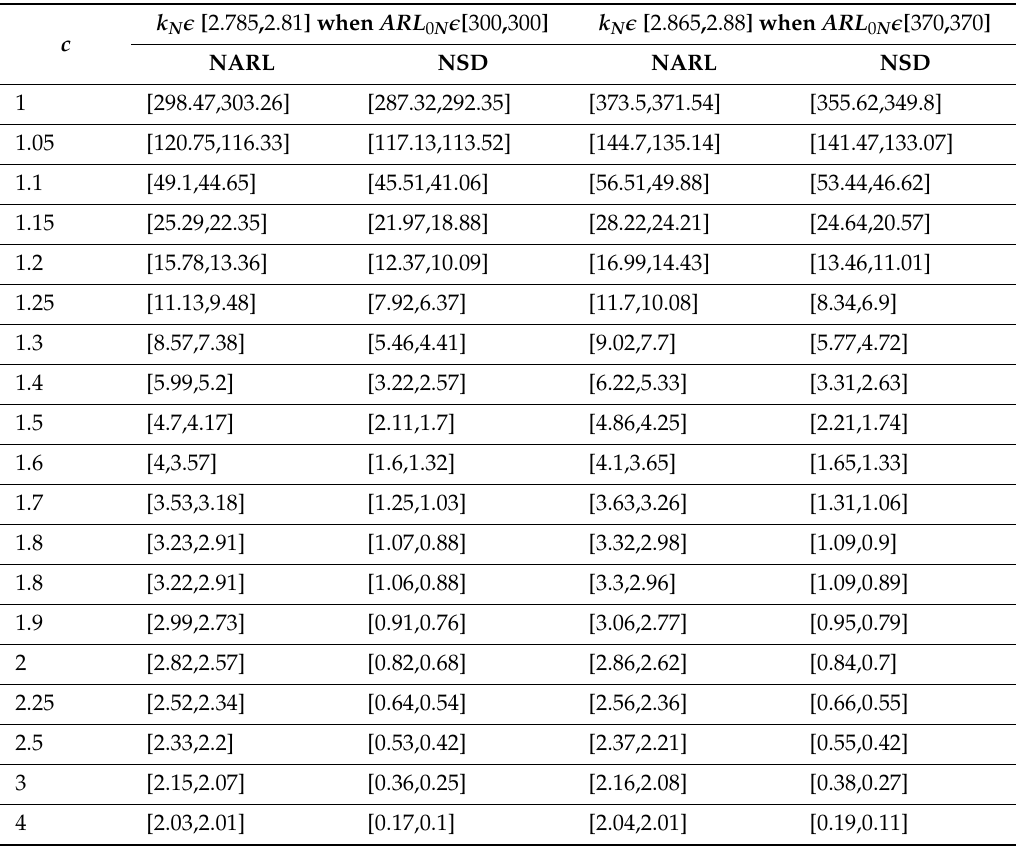
Table 7. The neutrosophic average run length (NARL) when n N (cid:15) [8,10] and λ N (cid:15) [0.28, 0.32].